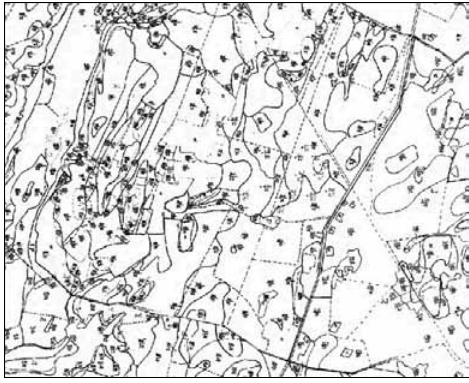
Fig. 1. Orthophotographic map Fig. 2. Productivity score of